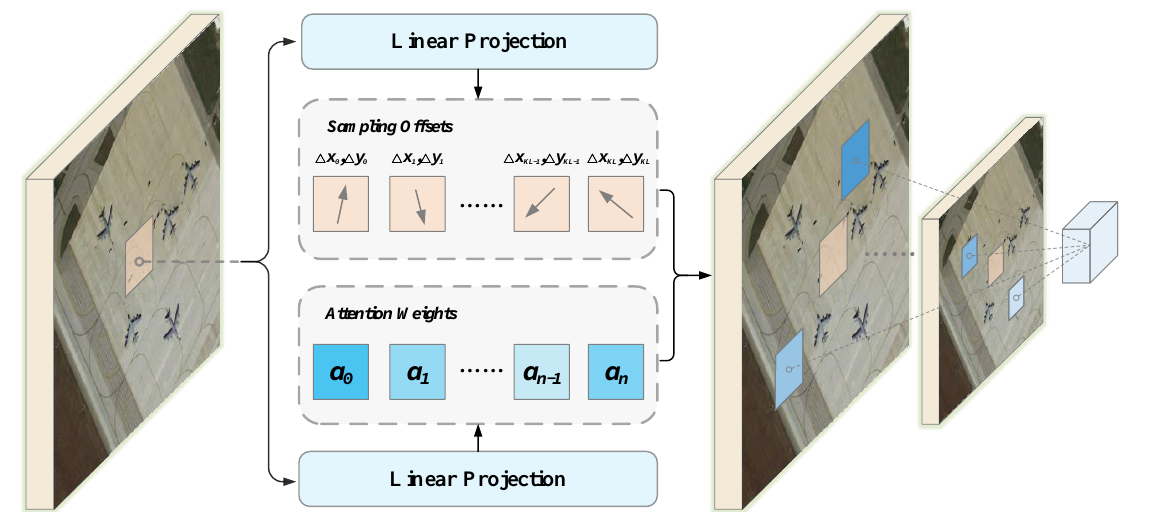
Figure 3. The diagram of the deformable attention module.